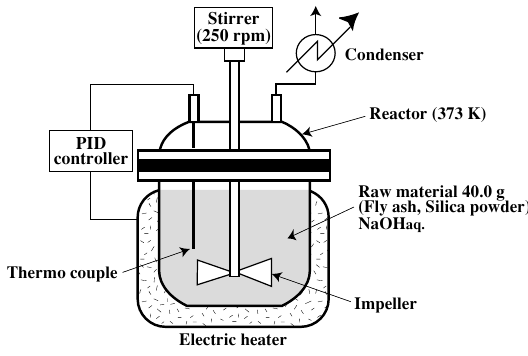
Table 1 Properties of tested fly ash and additive silica powder